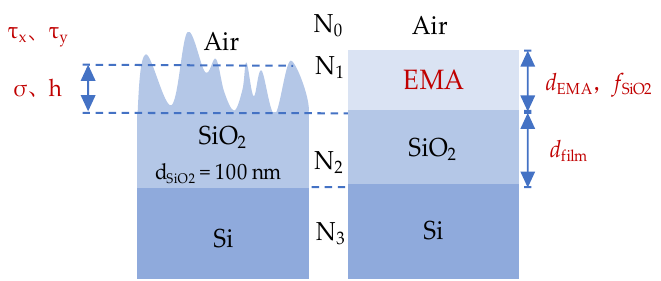
Figure 8. Optical model established in ellipsometry analysis.